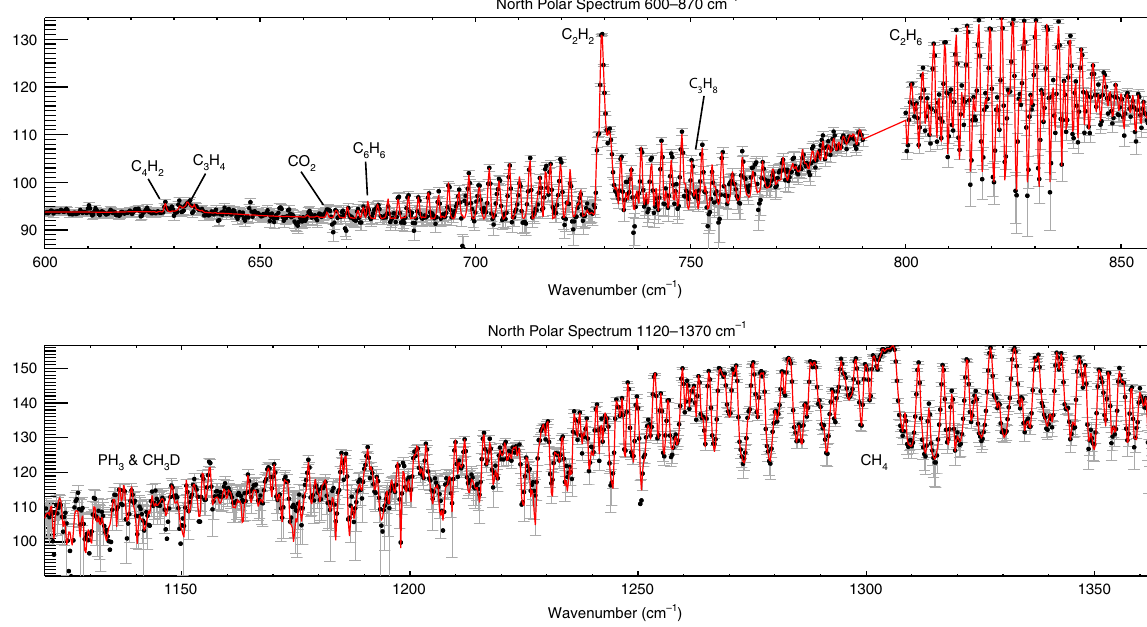
Fig. 5 Best- fi tting brightness temperature spectrum for the 0.5-cm − 1 resolution observation of the NPSV on March 27, 2017 (spanning 84 – 87°N). The fi gure shows the model fi t (red) to the data (black points with grey uncertainties). The fi gure is split into the two spectral ranges used in the inversions: a 600 – 870 cm − 1 and b 1120 – 1370 cm − 1 . Key gaseous features are labelled. Data between 870 and 1120 cm − 1 were omitted from the inversion. The measurement uncertainties (grey bars) depend on the number of coadded CIRS spectra and the number of deep space reference spectra used in the